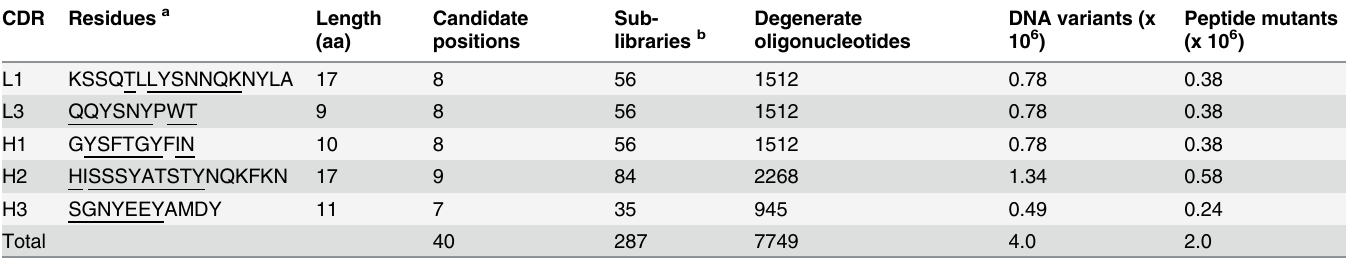
Fig 1. Overall scheme of the HuA21 affinity maturation process by phage display. (A) Candidate residues from the L1, L3, H1, H2 and H3 CDRs were targeted for diversification. (B) NWG, NWC and NSG degenerate codons were used for amino acid saturation mutagenesis. (C) Degenerate oligonucleotides containing CDR mutations were synthesized on microchips. (D) Mutant CDR libraries were amplified from the mixture of released oligonucleotides. (E) Mutant scFv gene libraries were assembled by OE-PCR and transformed into TG1. (F) Recombinant phages were amplified with helper phages, captured on antigen-coated magnetic beads, and recovered by re-infecting TG1. (G) Phage ELISA was used to isolate antigen-binding clones. (H) Positive clones were submitted for Sanger sequencing. (I) Pool of mutant CDR libraries was sequenced on the Illumina HiSeq 2000 platform. (J) NGS data was analyzed after quality filtration. (K) ScFv-Fc mutants were expressed in Expi293 cells to determine binding EC50s. doi:10.1371/journal.pone.0129125.g001 Table 1. Statistics of the SPM libraries for CDR